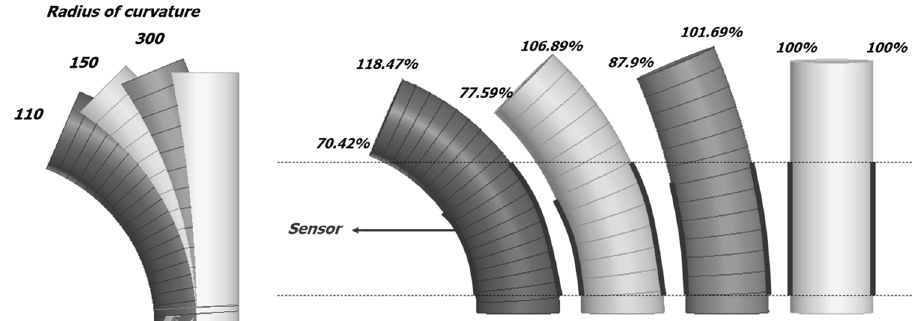
Figure 9. The rate of change in the lengths for the inside and outside surfaces according to change in curvature. Table 3. Resistance changes according to changes in length of inside and outside sensors. 300